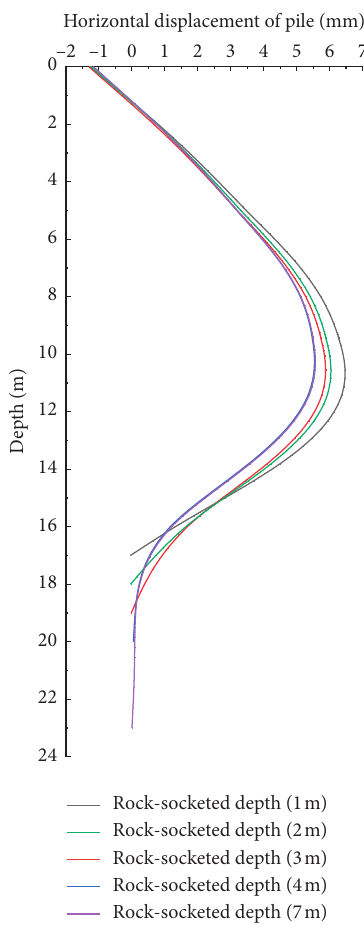
Figure 18: Horizontal displacement of the